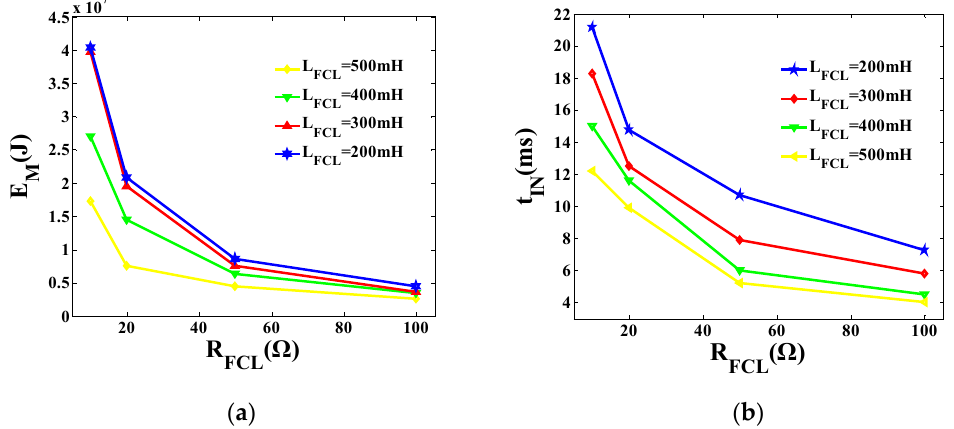
Figure 22. Characteristic curves of absorbed energy and interruption time under variables ( a ) R FCL and ( b ) L FCL